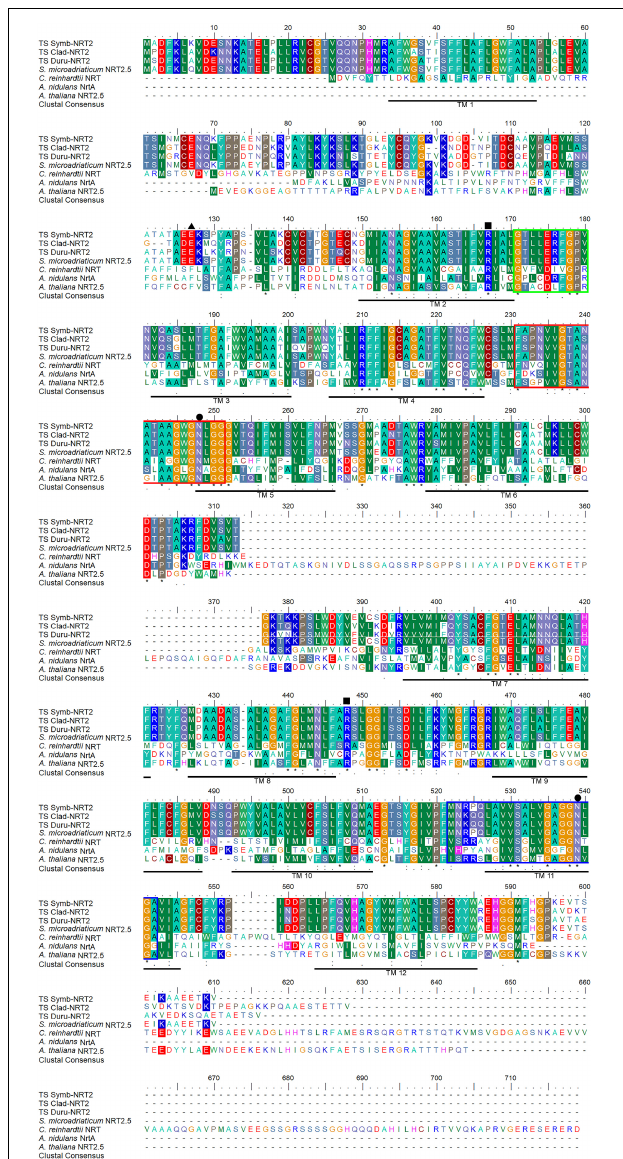
FIGURE 1 | Molecular characterization of the deduced amino acid sequences of nitrate transporter 2 from Symbiodinium (Symb-NRT2), Cladocopium (Clad-NRT2), and Durusdinium (Duru-NRT2) obtained from the outer mantle of Tridacna squamosa . Multiple alignment of Symb-NRT2 (MZ014639), Clad-NRT2 (MZ014640), and Duru-NRT2 (MZ014641) with Symbiodinium microadriaticum NRT2.5 (OLQ11495.1), Chlamydomonas reinhardtii NRT (XP_001694496.1), Aspergillus nidulans NrtA (AAA76713.1), and Arabidopsis thaliana NRT2.5 (NP_172754.1). Shaded residues indicate identical or similar amino acid residues. Asterisks denote identical amino acid residues, colons denote strongly similar amino acids, and periods denote weakly similar amino acids. The twelve predicted transmembrane regions (TM 1–TM 12) underlined in black were predicted using TMpred provided by ExPASy Bioinformatics Resource portal. Black boxes denote substrate-binding residues. Hydrophobic residues and polar residues that make up the gate at the substrate binding site are indicated with black triangles and black circles, respectively. The two nitrate signature regions, NS1 and NS2, are marked with red and blue boxes, respectively: [FYK]-X 3 -[ILQRK]-X-[GA]-X-[VASK]-X- [GASN]-[LIVFQ]-X 1 , 2